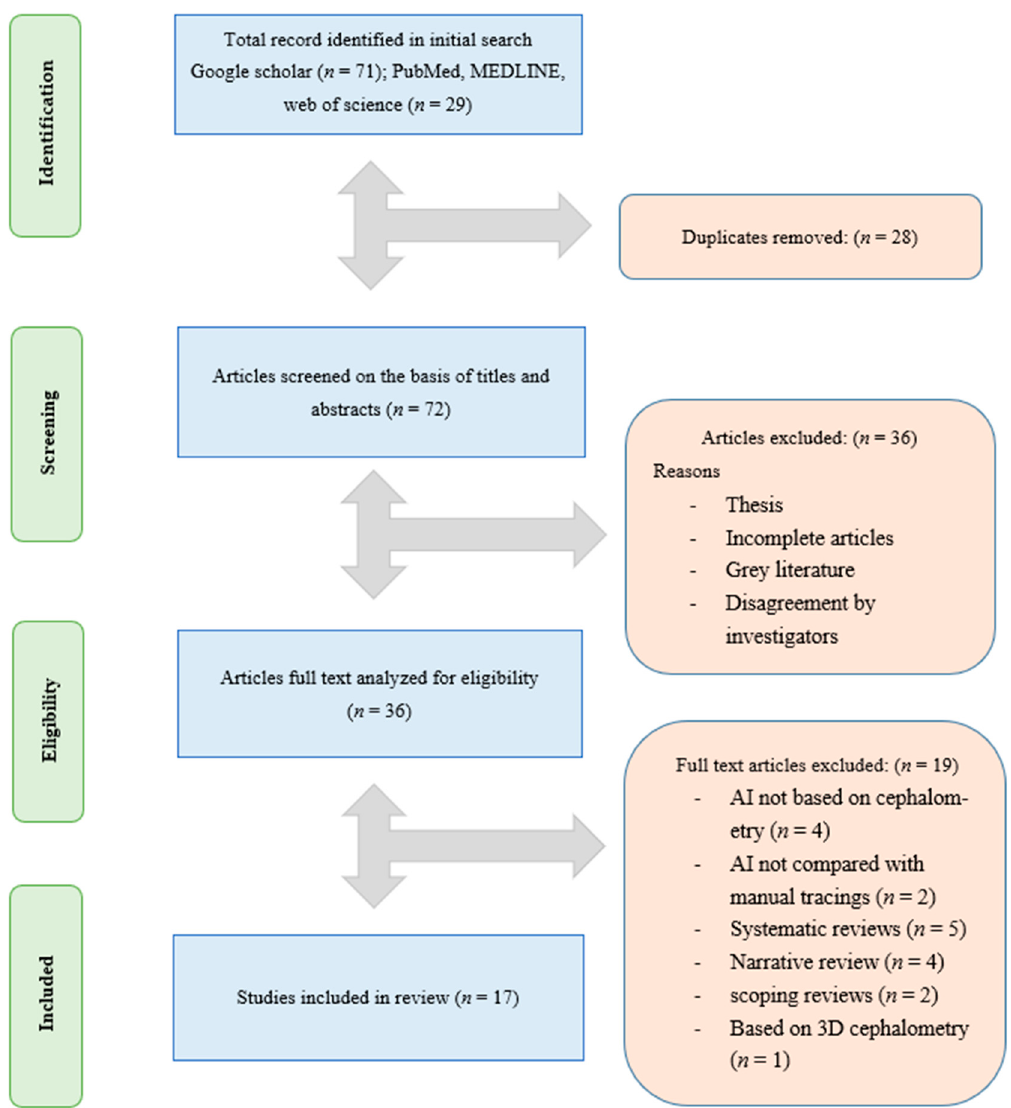
Figure 1. The PRISMA flow diagram for the literature search performed in this study.